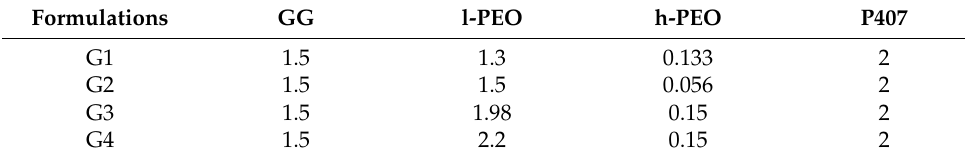
Table 1. Composition of the polymeric solutions for electrospinning, expressed as % w / w .